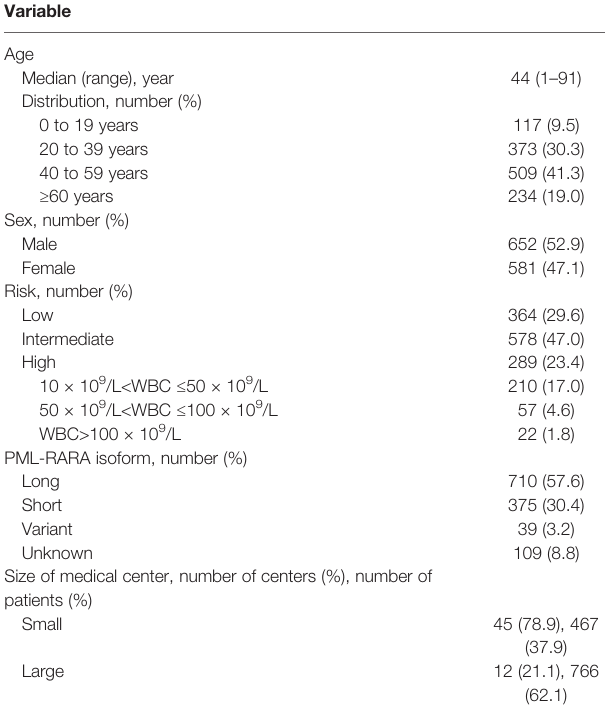
TABLE 1 | Characteristics of the patients at